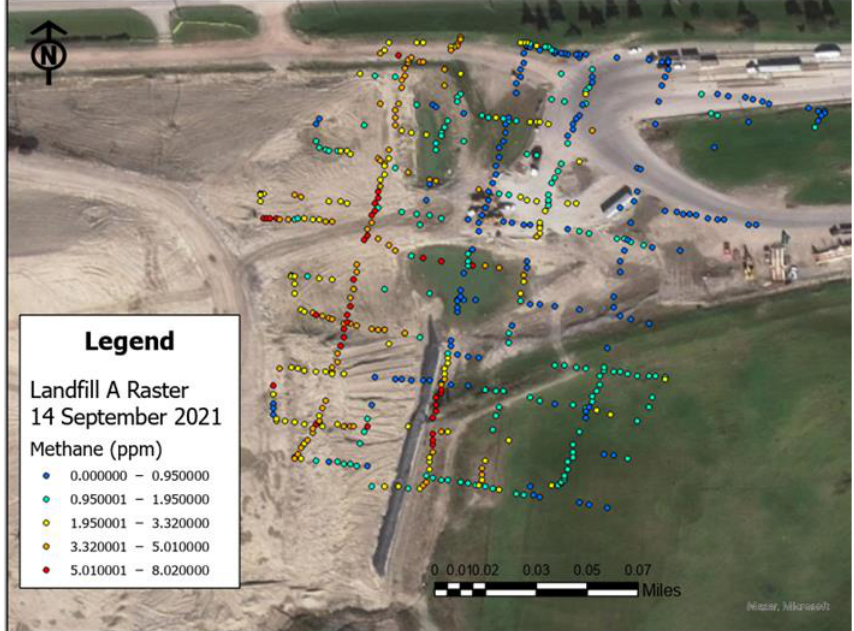
Figure 10. Methane concentrations measured in the interior of Facility A on 14 September 2021, 9:04 a.m. to 9:23 a.m. The maximum altitude of measurements was roughly 40 m above the set point.